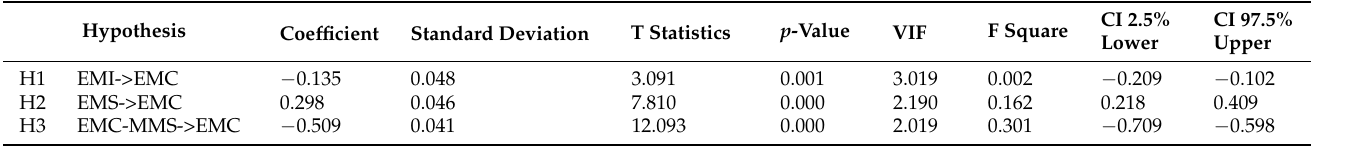
Table 6. Hypothesis